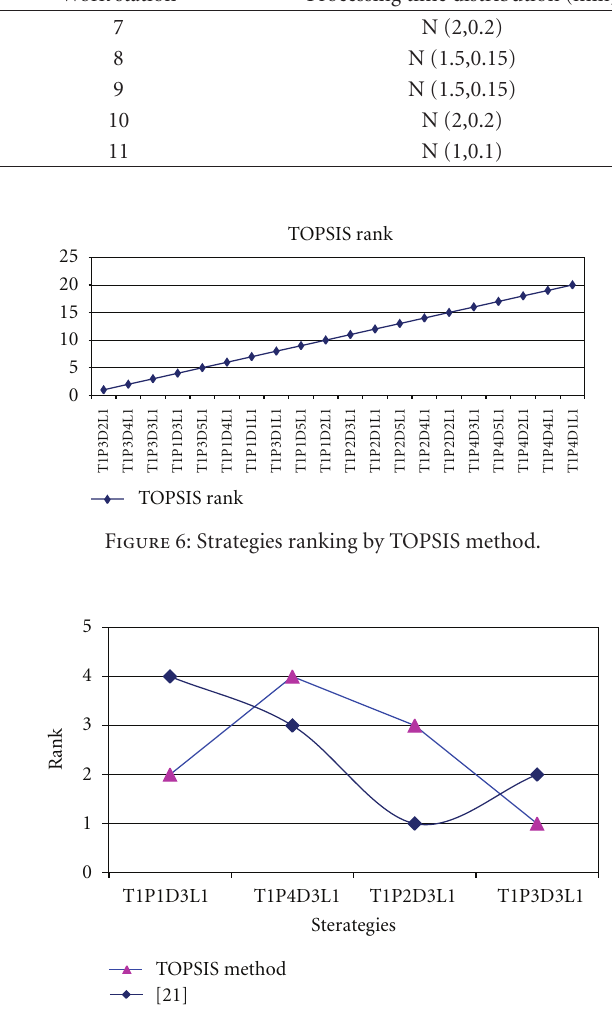
Figure 7: TOPSIS method versus [21] results.